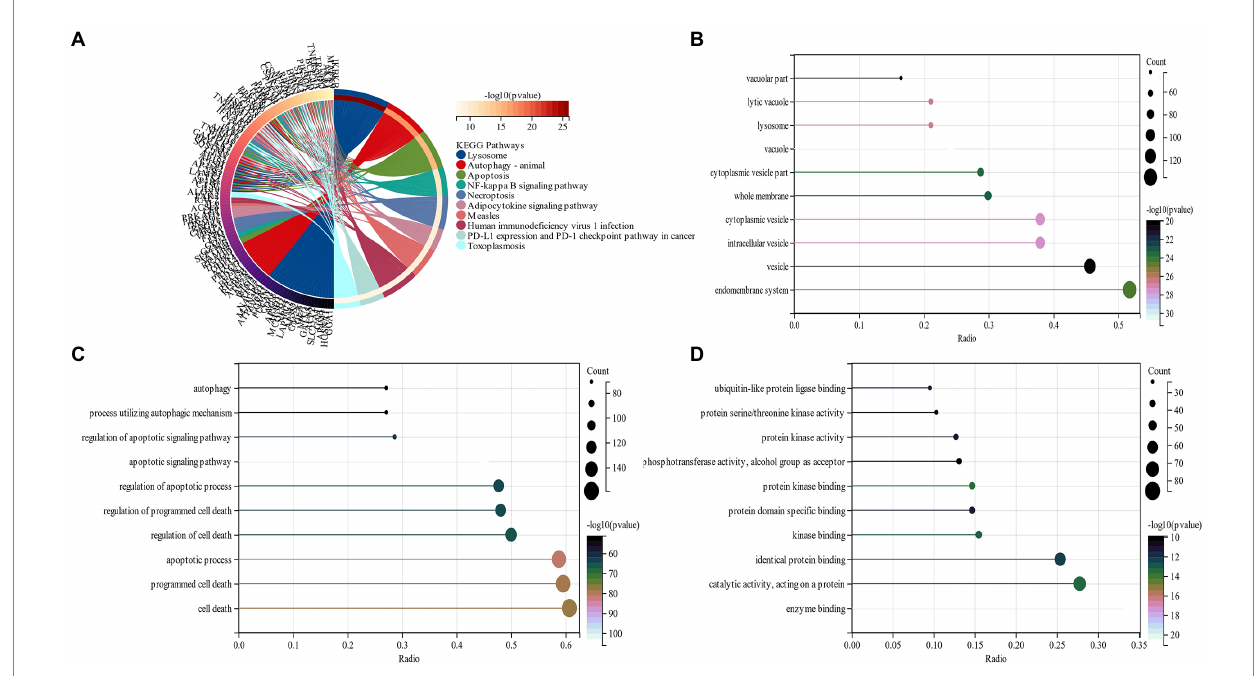
FIGURE 3 (A) An analysis of KEGG pathways at the intersection of genes. Genes enriched in different pathways are represented by different colors; (B) GO analysis of cell components of candidate genes (CC); (C) GO analysis of the biological process of candidate genes (BP); (D) GO analysis of the molecular function of candidate genes